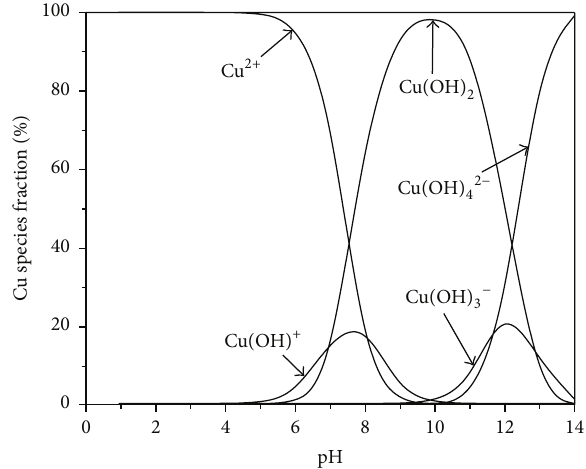
Figure 4: Cu species distribution at different pH.